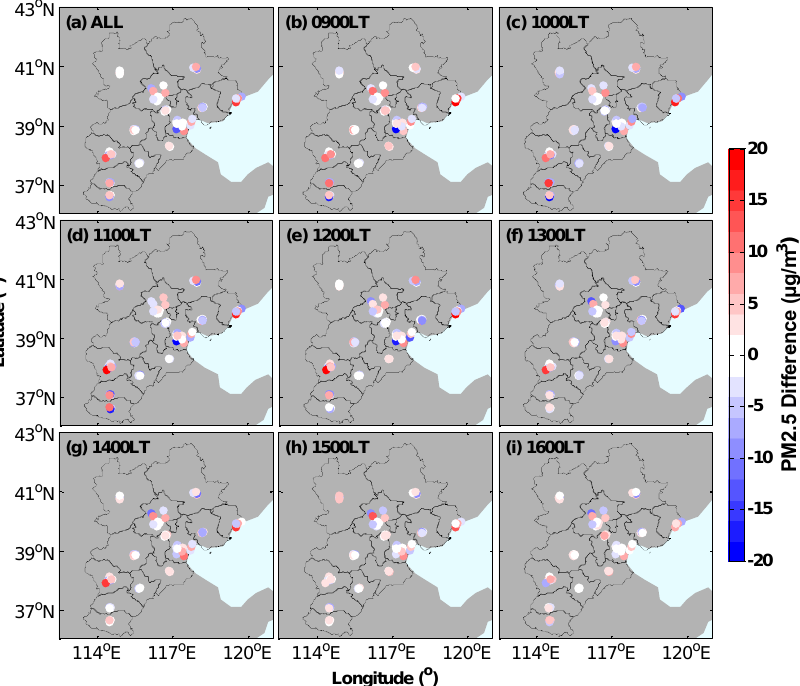
Figure 6. Differences in estimated and measured PM2.5 for individual PM monitoring sites: ( a ) all available data; ( b – i ) different hours (0900–1600 local time).